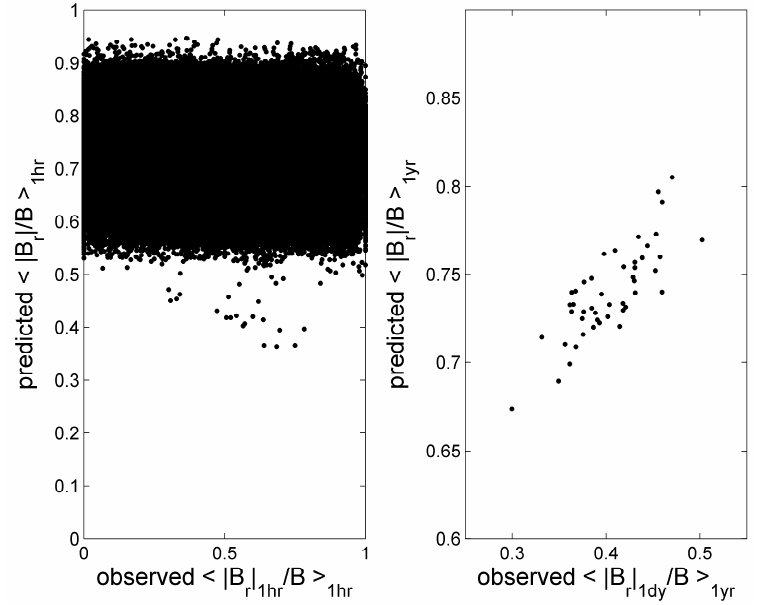
Figure 11: Scatter plots of the predicted ratio | 𝐵 𝑟 | /𝐵 from Parker spiral theory, where 𝐵 is the IMF magnitude and | 𝐵 𝑟 | is the modulus of its radial component, as a function of the observed value of that ratio. The left-hand plot is for hourly observations, the right-hand plot for 1-year averages. In the case of the annual means, the modulus of daily means of 𝐵 𝑟 observations, i.e., ⟨| 𝐵 𝑟 | 1d ⟩ 1yr , is